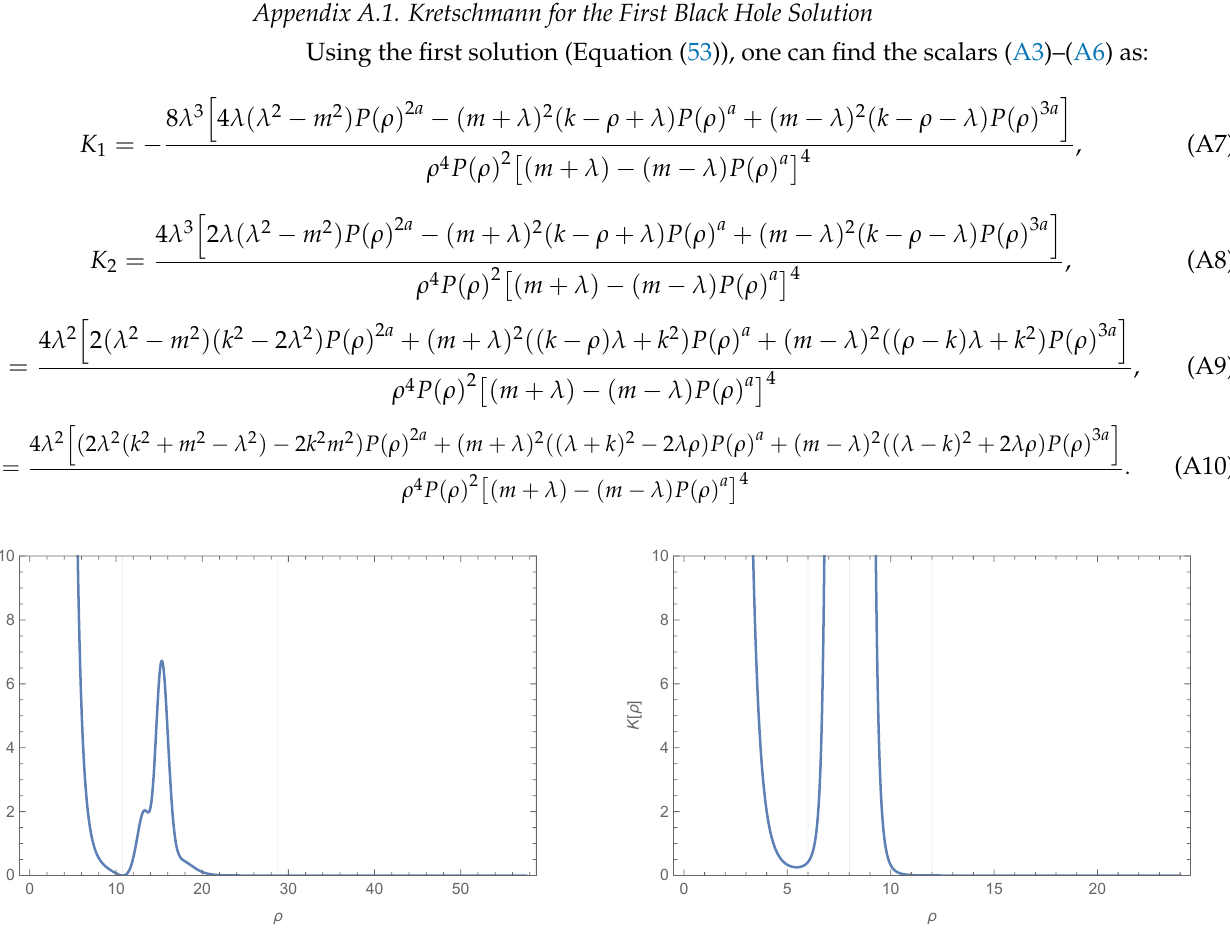
Figure A1. Plot of the Kretschmann scalar for the first solution (Equation (68)) with a odd (left figure) and with a even (right figure). The vertical lines in the left figure indicate the horizons, while in the right figure, the left and right vertical lines are the horizons and the one in the middle is the second singularity of the case of a even, showing that the solution ends there, excluding the inner horizon. The values of the parameter used here are the same as in the plots of Figures 1 and